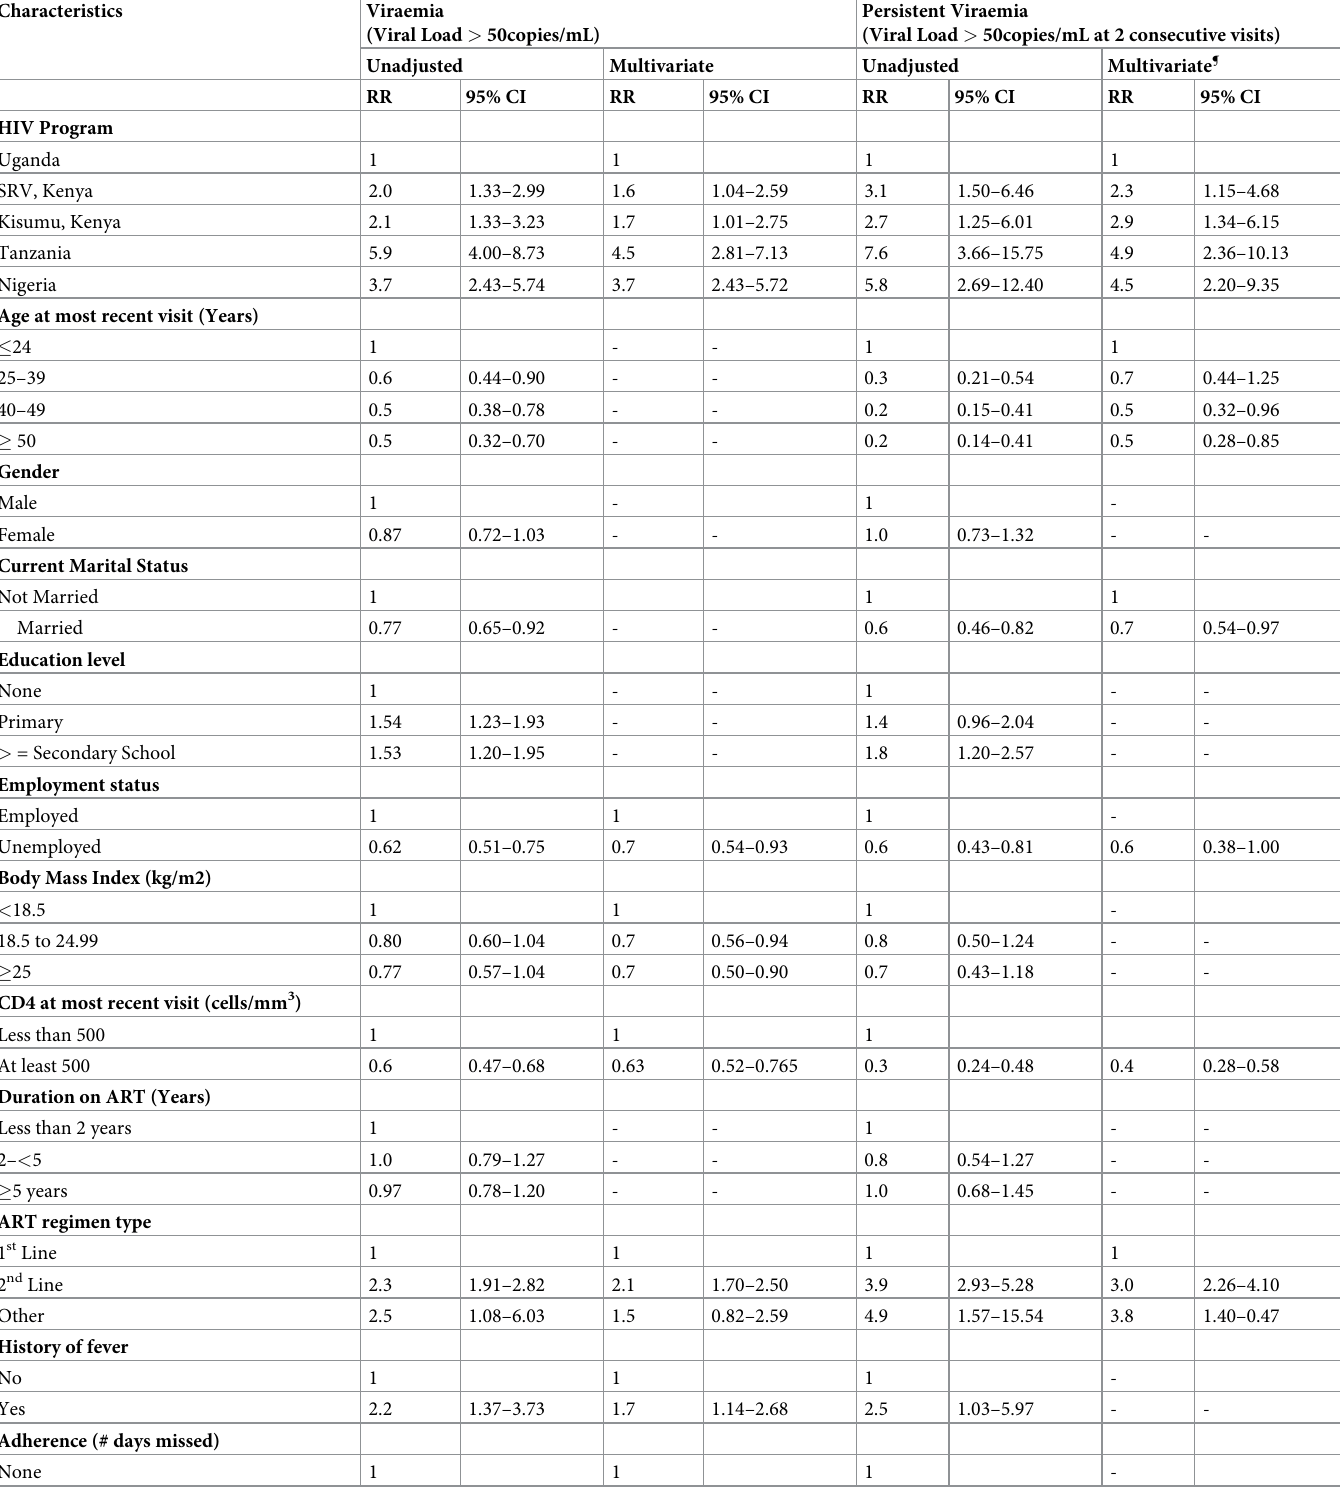
Table 3. Unadjusted and adjusted factors associated with viraemia.